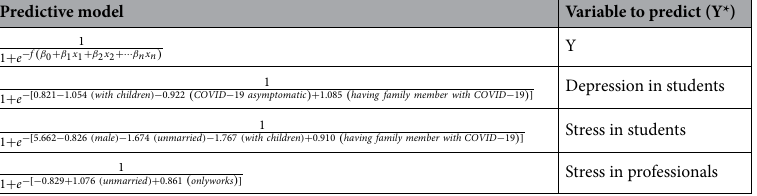
Table 7. Building predictive models for depression, anxiety and stress. Y*: dependent variable (depression or stress), e: base of natural logarithm, f (x) : function of probable cause (x = predictor variable), β 0 : constant coefficient of determination, Β n : coefficient of determination of independent variable. Note: The categories of predictor variables included in the model should take value 1; any other category of variable X that was not considered as predictor, should be considered with valor